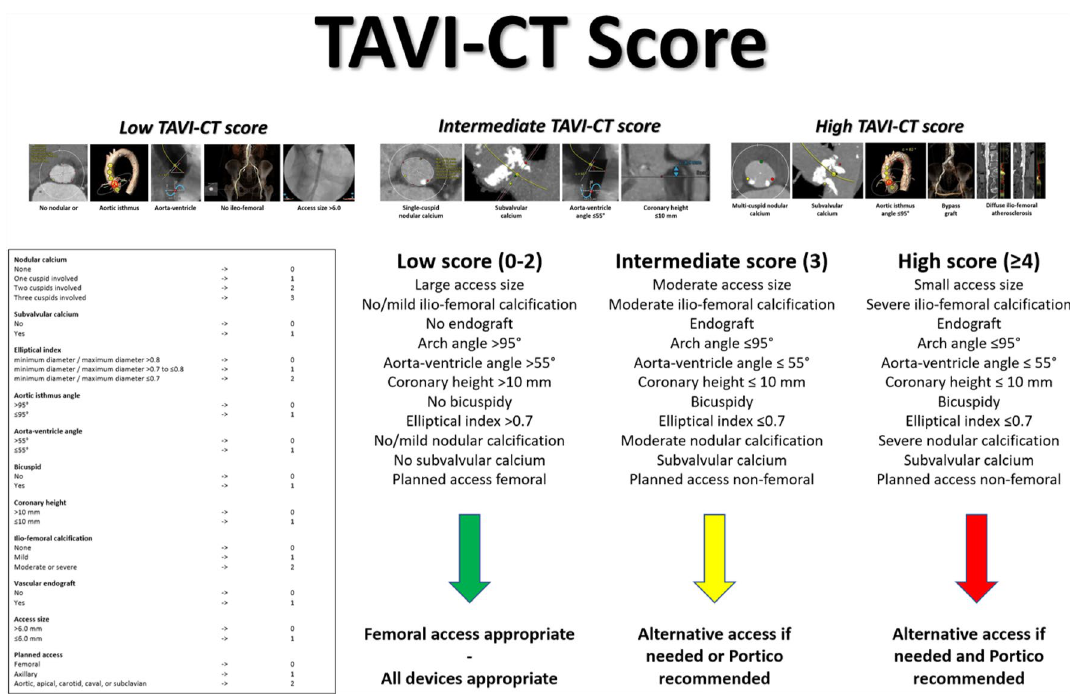
Figure 2. Approach to compute and apply the TAVI-CT (transcatheter aortic valve implantation-computed tomography) score for